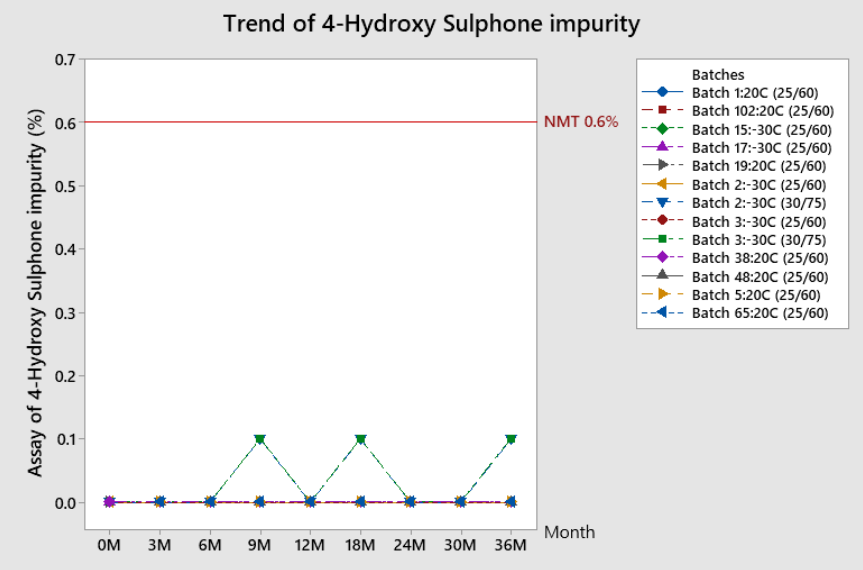
Figure 9. Trend of 4-hydroxy sulphone impurity for stability batches. Trend of 4-Hydroxy-Sulfide Impurity The trend of 4-hydroxy-sulfide impurity results obtained during the stability study is given in Figure 10.